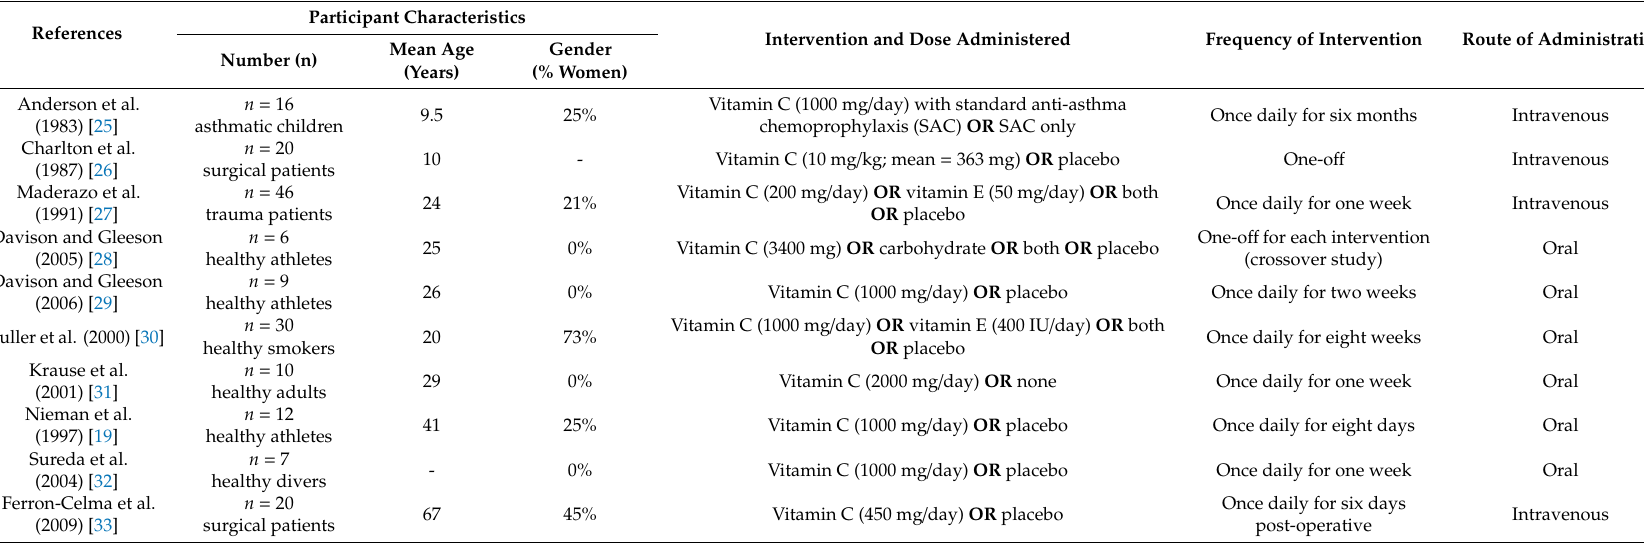
Table 3a. The participant characteristics and interventions used, the frequency of intervention and the route of administration for vitamin C-only